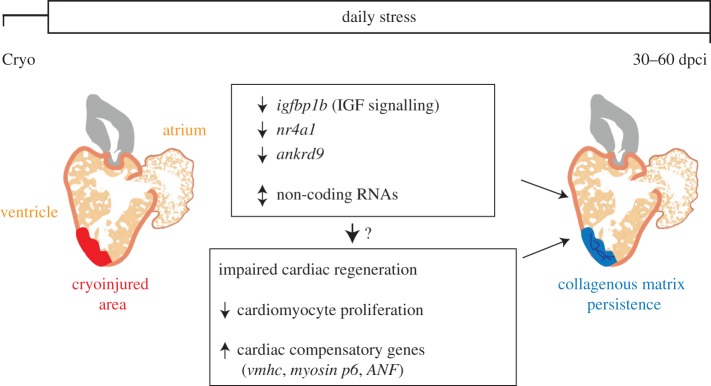
Stress suppresses CM proliferation resulting in impaired heart regeneration. Daily exposure to stress after cryoinjury leads to a delay in cardiac regeneration with scar persistence. Among the potential mechanisms underlying this negative effect, the stress-induced elevation of cortisol secretion appears to drive a shift from CM proliferation to other cardiac compensatory responses. In addition, daily acute stress is associated with significant changes in gene expression, such as the downregulation of igfbp1b, nr4a1 and ankrd9 in non-myocytes of the ventricle, indicating a non-cell-autonomous effect of stress on cardiac regeneration.